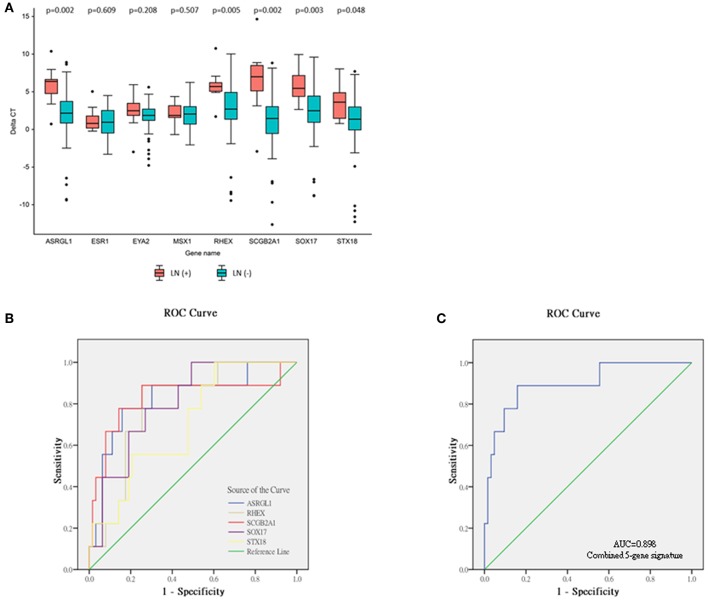
Relative expression levels of eight genes selected from validation cohort, and ROC analyses of single-mRNA/five-mRNA expression. (A) Data expressed as (threshold cycle of corresponding gene—threshold cycle of RPL19). A positive delta CT indicates lower expression than that of reference gene RPL19. Significant difference determined using the Mann–Whitney U-test in five genes—ASRGL1, RHEX, SCGB2A1, SOX17, and STX18. (B) ROC curve of expression of five single mRNAs. (C) ROC curve of combined five-mRNA expression.